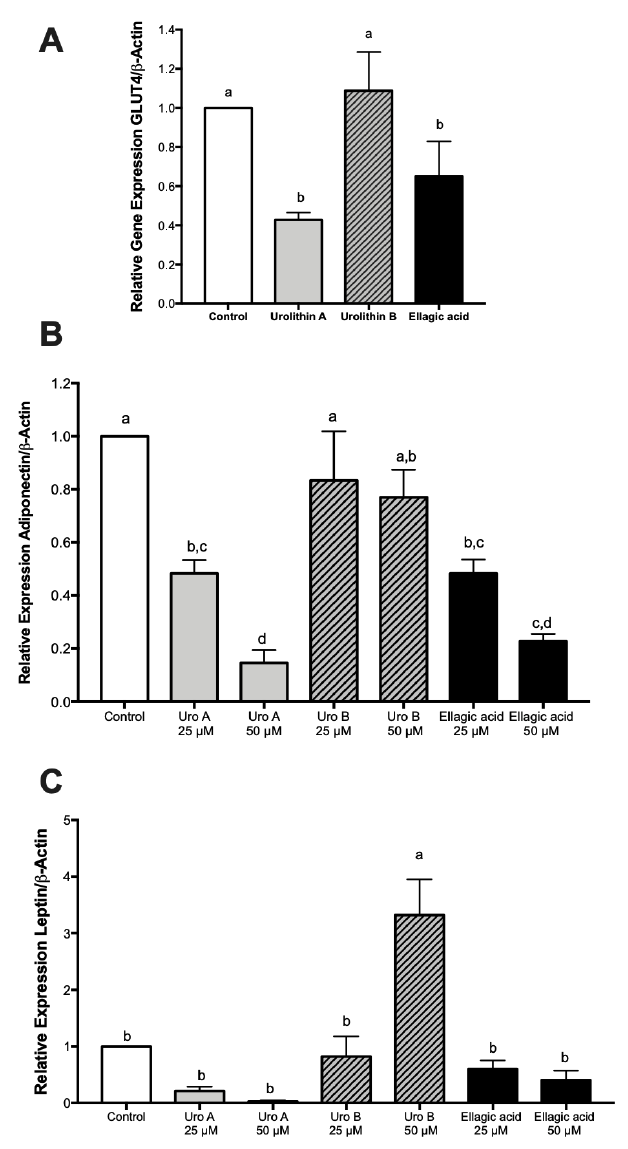
Figure 6. Effect of ellagic acid, urolithin A, and urolithin B on the gene expression of glucose transporter type 4 (GLUT4), adiponectin, and leptin in 3T3-L1 adipocytes. The gene expression of GLUT4 with treatments at 25 µM ( A ), and gene expressions of adiponectin ( B ) and leptin with treatments at 25 and 50 µM ( C ) was determined by RT-PCR after 8 days of treatment with the compounds, as described in the Materials and Methods section. The values represent the mean ± SD ( n = 3) of three independent experiments. Different letters among bars denote significant changes among treatments and control ( p ≤ 0.05) performed by ANOVA and Tukey’s post hoc test.